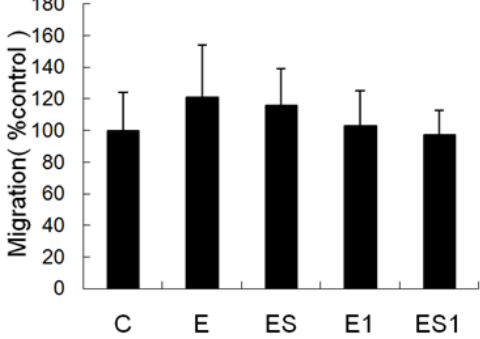
Figure 4. Effects of strenuous exercise and BCAA supplementation on the chemotaxis of MФs. MФs were added into the upper chambers of a 24-well transwell plate, while MCP-1 was added into the lower chambers of the transwells to induce migration. The number of migrated cells was counted. Data were expressed relative to control group cell migration. Data are means ˘ SD.